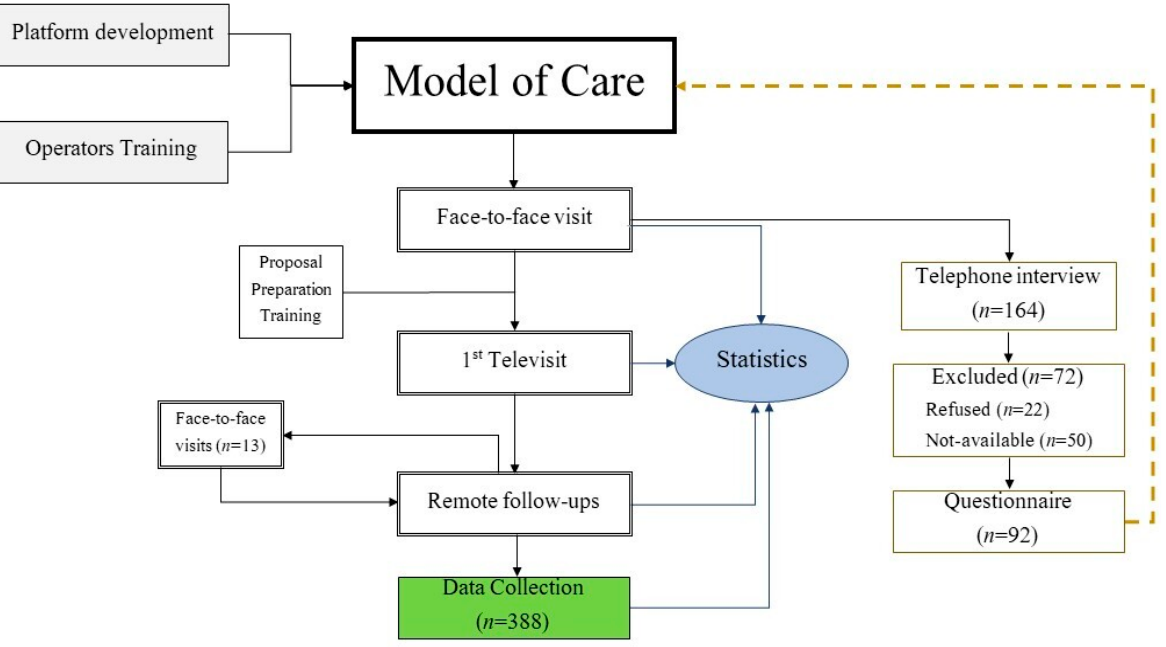
Figure 1. Model of care and the study flowchart. The model of care is designed through the